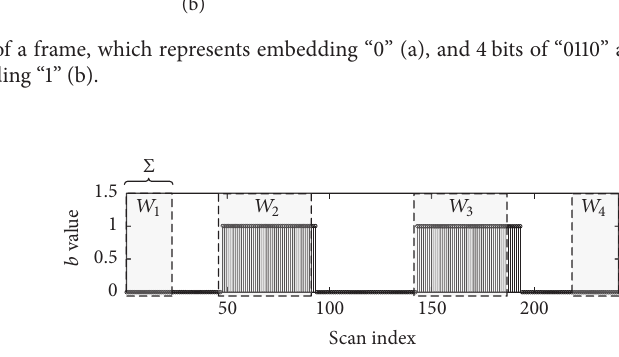
Figure 18: Example of performing the four windows on Scan [𝑌 𝑖 ] . Table 1: Conditions for stopping frame-scan operation. Note that “ ∘ ” is “The concavity of singular spectrum can be detected,” and “ × ” is “The concavity of singular spectrum cannot be